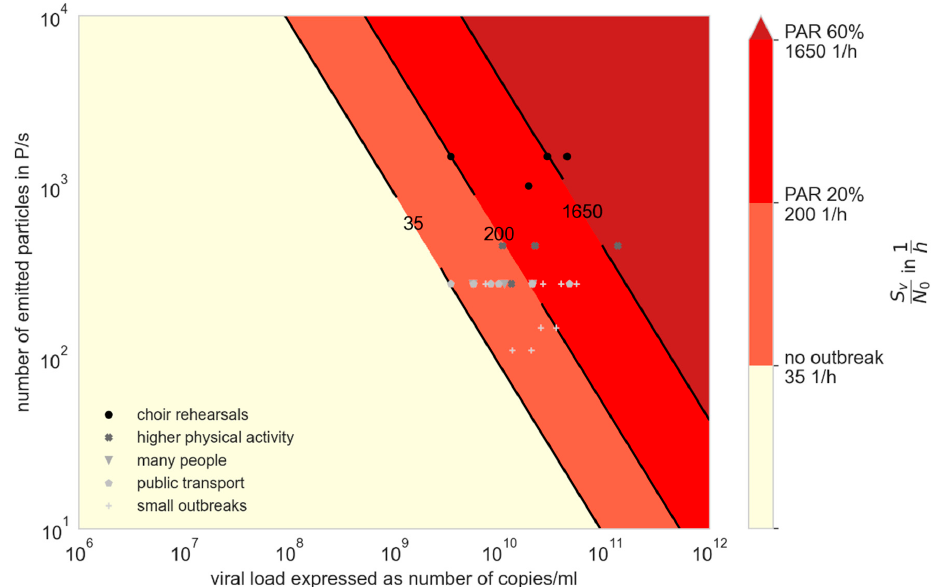
Figure 4. Virus factor (VF) for different viral loads and particle emission rates with N 0 = 300 viral copies. The attack rates found in the investigated outbreaks are shown with the different colors; the markers show the amount of virus factor at assumed mean particle emission rate of the related activity according to Figure 2.